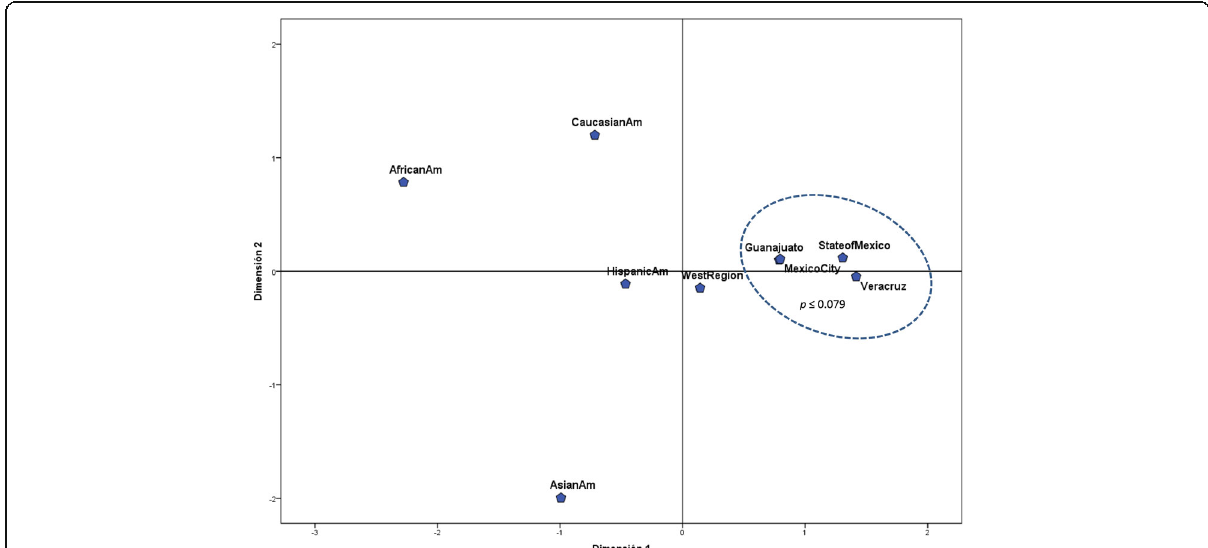
Fig. 3 MDS plot that shows genetic relationships between Mexican-Mestizo and four American populations based on the Powerplex 16